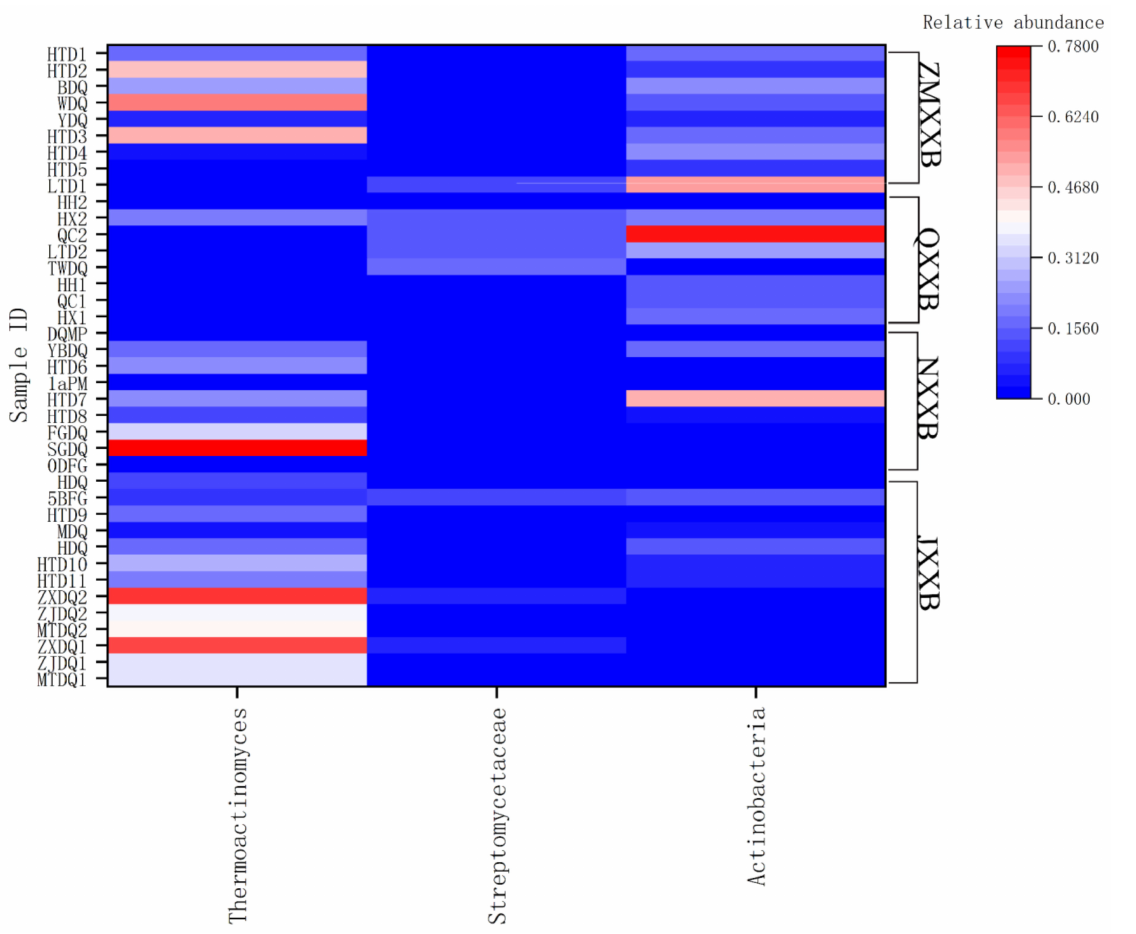
Figure 2. Relative abundance heatmap of Thermoactinomyces and actinomycetes in DQ samples obtained from high-temperature Daqu (HTD), white Daqu (WDQ), yellow Daqu (YDQ), black Daqu (BDQ), low-temperature Daqu (LTD), Taiwanese Daqu (TWDQ), the Daqu-making process (DQMP), Yibin Daqu (YBDQ), 1-year-old pit mud (1aPM), first-grade Daqu (FGDQ), special-grade DQ (SGDQ), 0-day fermented grain (0DFG), Hongtudi distillery Daqu (HDQ), 5th fermentation round FG (5BDQ), M-type Daqu (MDQ), H-type Daqu (HDQ), Zhongxin Daqu(ZXDQ), Zhenjiu Daqu (ZJDQ), and Maotai DQ (MTDQ)